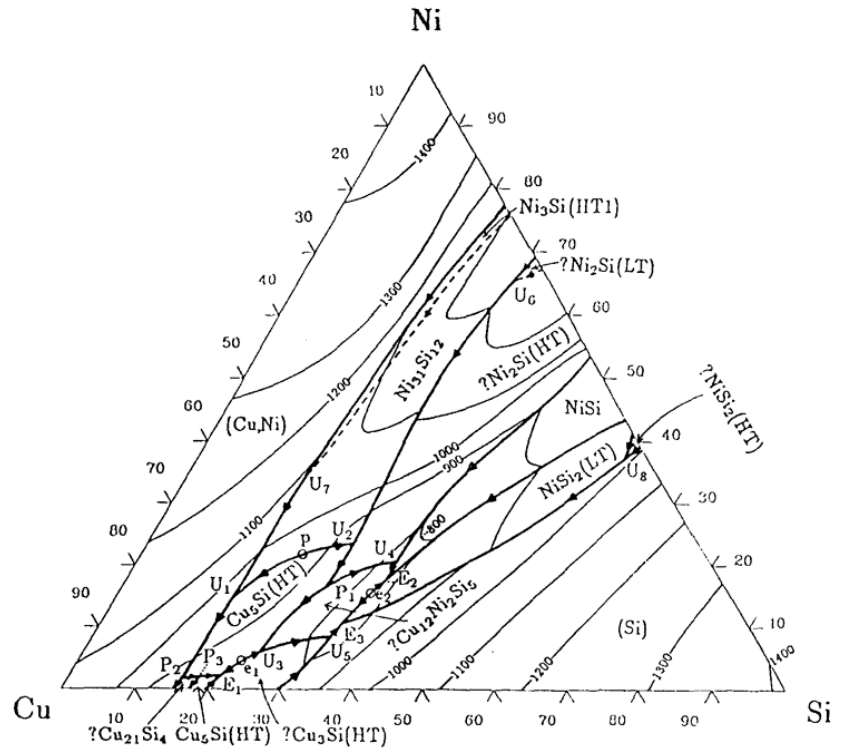
Figure 1. Liquidus projection in the Cu–Ni–Si three-substance system